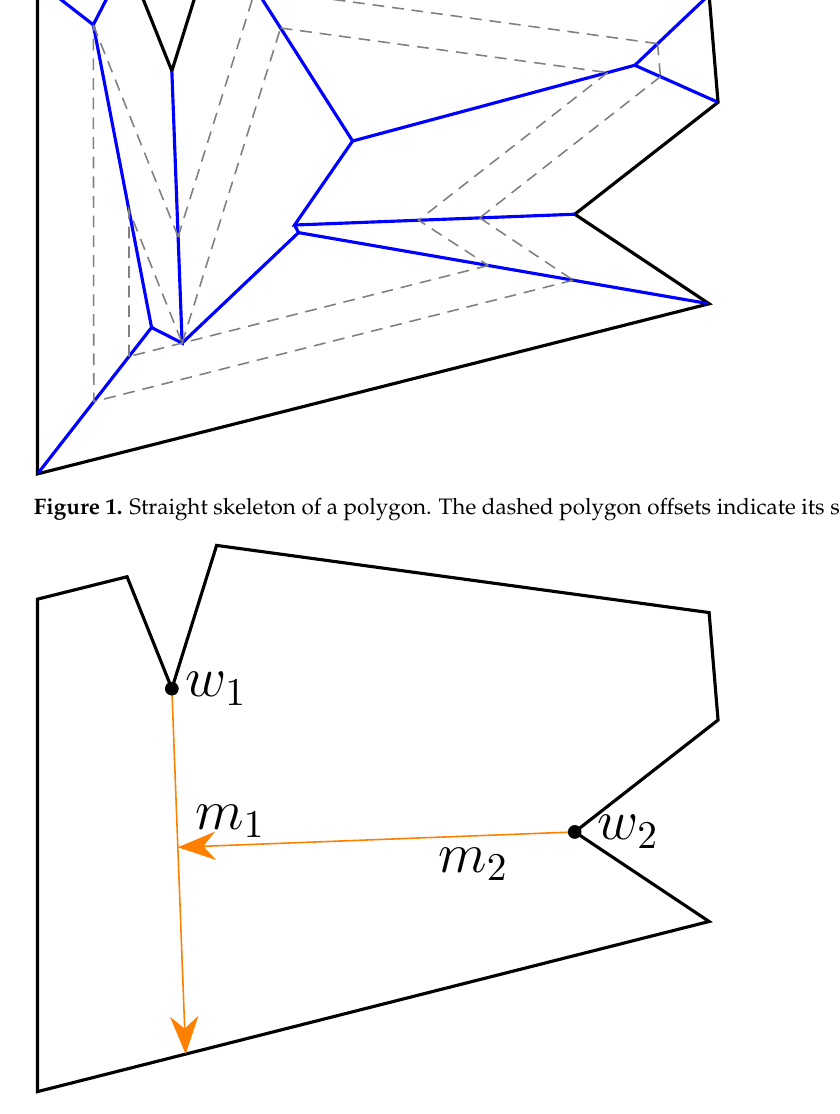
Figure 2. The corresponding motorcycle graph is defined by two motorcycles, m 1 and m 2 , that start at the reflex vertices w 1 and w 2 ,